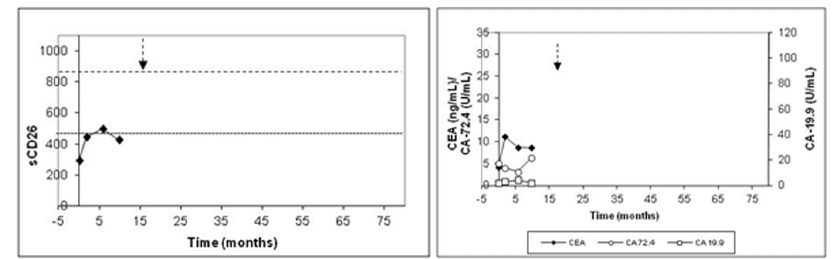
Figure 2. Levels of the sCD26, CEA, CA-19.9 and CA-72.4 in a representative individual (patient 42) with tumor persistence. The dashed arrow shows exitus .